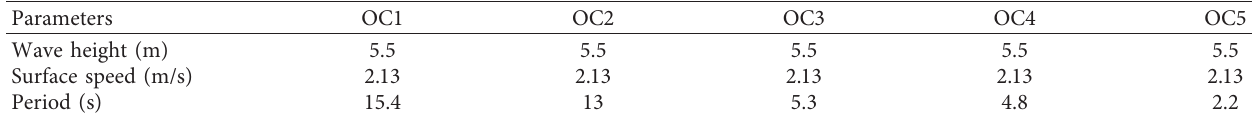
Figure 2: : The first 6 order modal shapes of the SCR: (a) 1 st order, (b) 2 nd order, (c) 3 rd order, (d) 4 th order, (e) 5 th order, and (f) 6 th order. Table 2: Parameters of considered oceanic